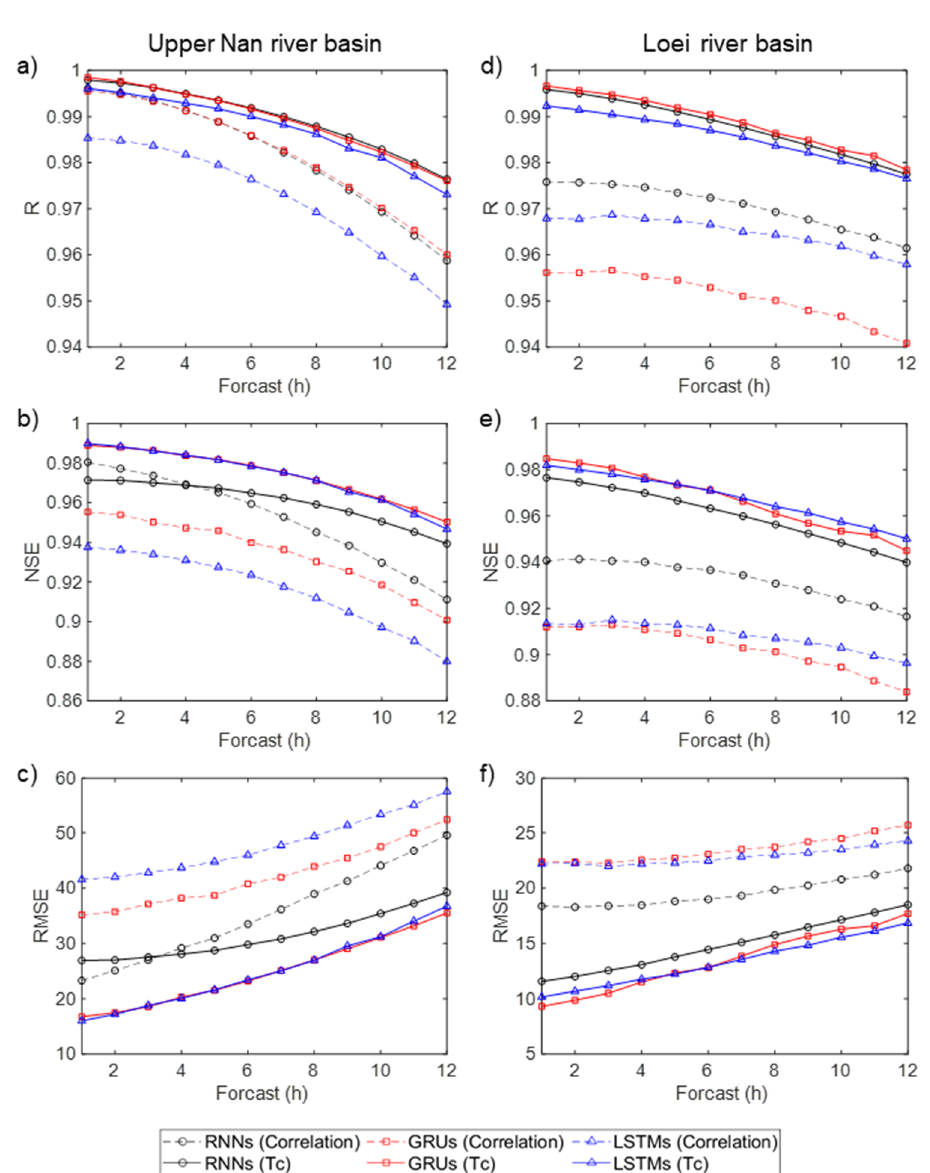
Figure 7. A comparison of R, RMSE and NSE for correlation-based and T C -based features using deep learning models for the Upper Nan ( left ) and Loei ( right ) river basins. ( a ) R on the Upper Nan river basin; ( b ) NSE on the Upper Nan river basin; ( c ) RMSE on the Upper Nan river basin; ( d ) R on the Loei river basin; ( e ) NSE on the Loei river basin; ( f ) RMSE on the Loei river basin.